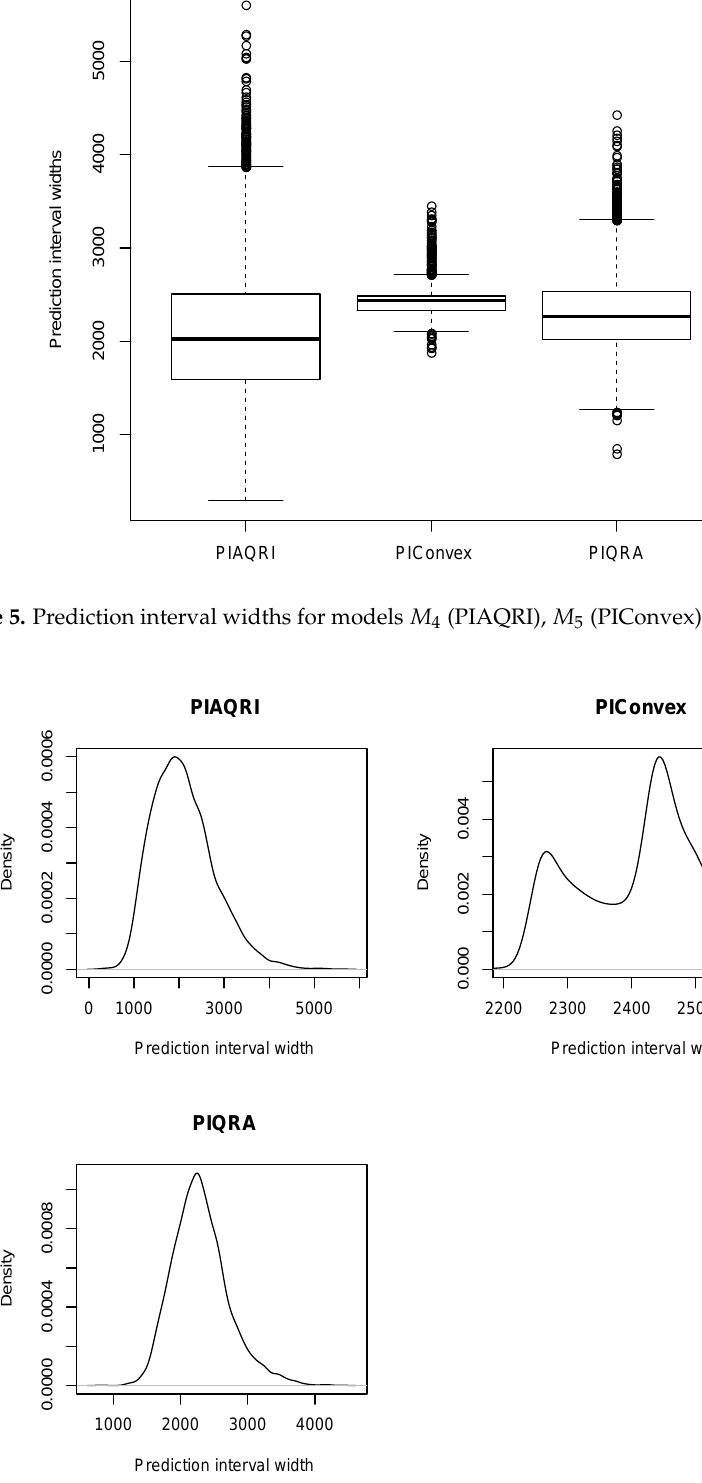
Figure 6. Density plots of the prediction interval widths for models M 4 (PIAQRI), M 5 (PIConvex) and M 6